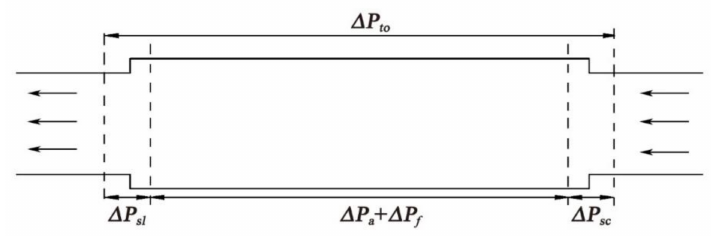
Figure 4. Schematic diagram of pressure